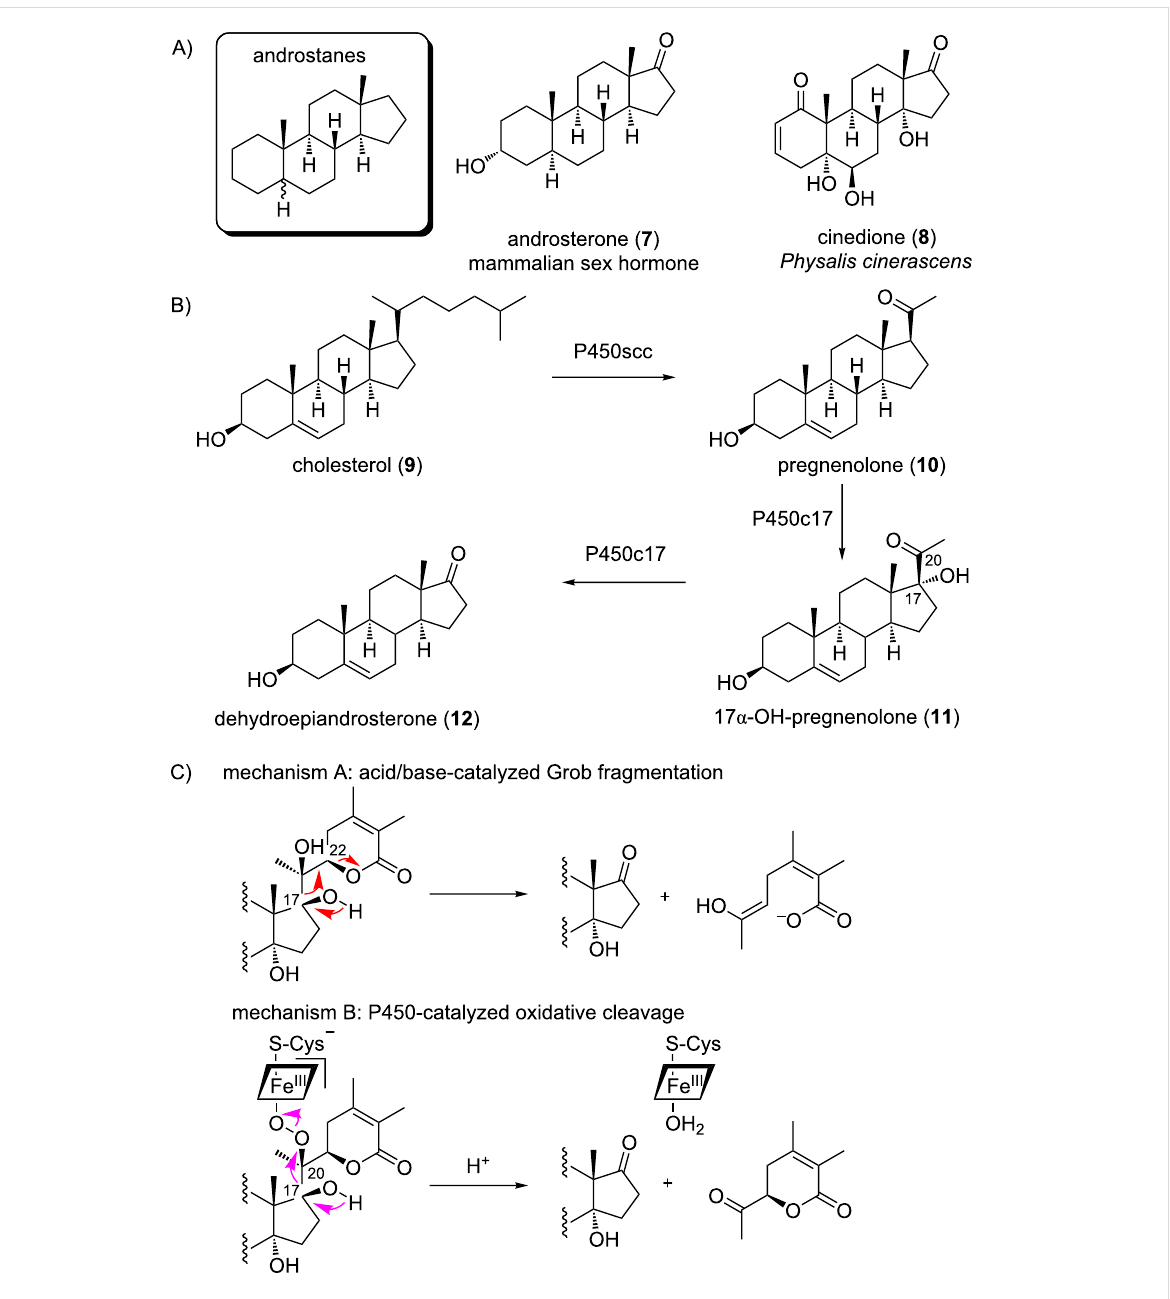
Figure 3: Structures and biosynthesis of androstanes. (A) Androstane backbone and androsterone ( 7 ) as a typical mammalian sex hormone. Cine- dione ( 8 ) is the only other fully characterised androwithanolide known. (B) Biosynthesis of androstanes in mammals. (C) Possible cleavage mecha- nisms involved in androwithanolide biosynthesis in